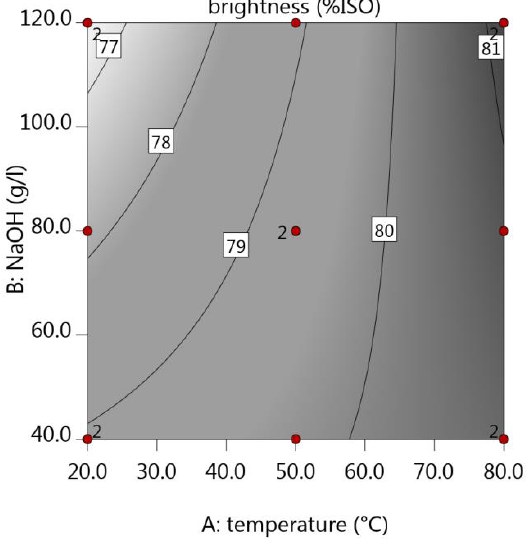
Figure A2. Response surface of brightness in correlation with temperature and NaOH concentration.